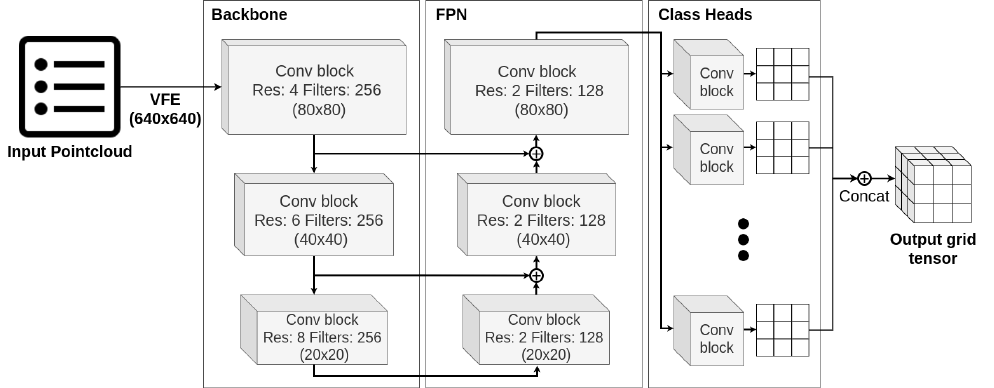
Figure 4. Proposed object detection LiDAR network architecture. Input pointcloud is processed voxel-wise by VFE block. Then, Backbone and FPN convolutional blocks form a U-shaped core network. Lastly, per class prediction heads yields output grids, which are concatenated into an output tensor.